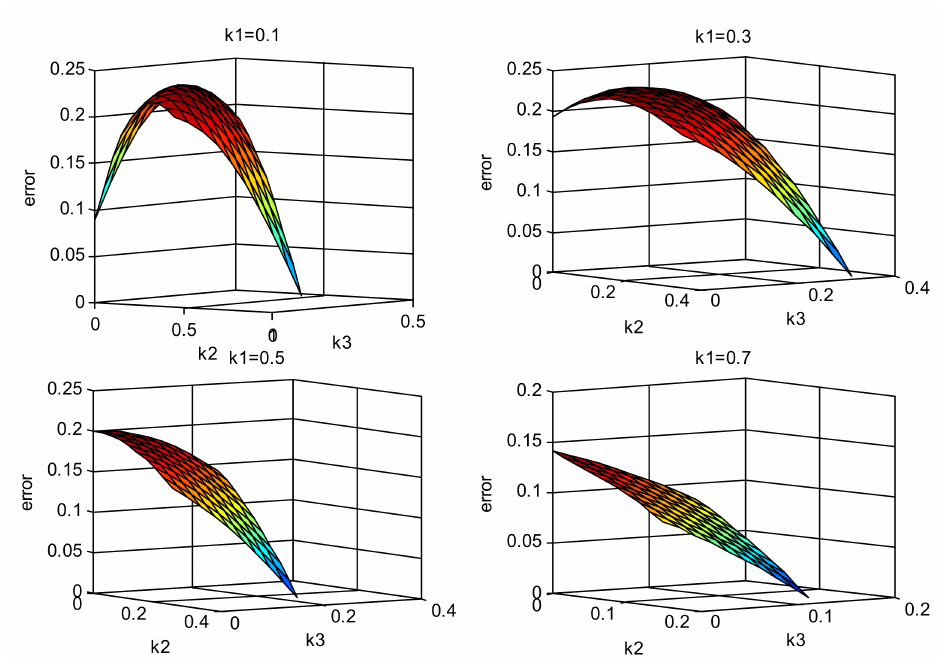
Figure 8. E ff ect of k 2 and k 3 on the system ISE value for di ff erent k 1